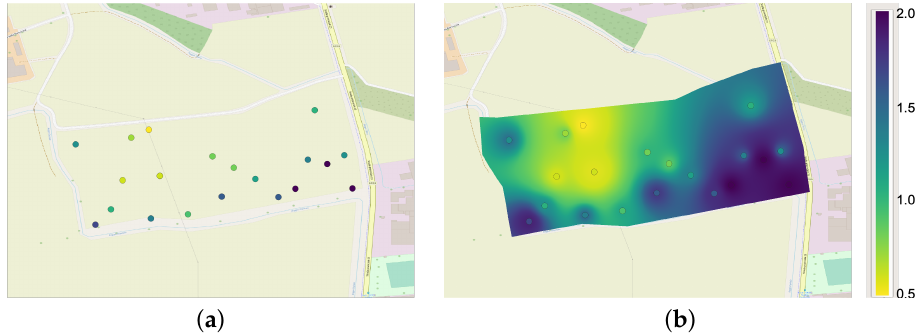
Figure 7. Example of Organic Carbon visualization: ( a ) soil sample; ( b ) soil mapping obtained using IDW interpolation.